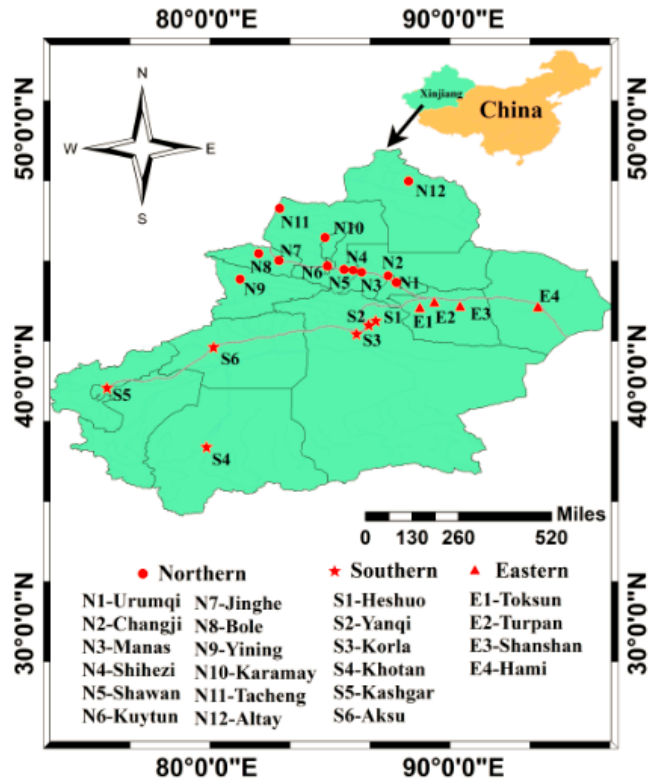
Figure 1. The distribution of sampling sites in northern, southern and eastern Xinjiang.